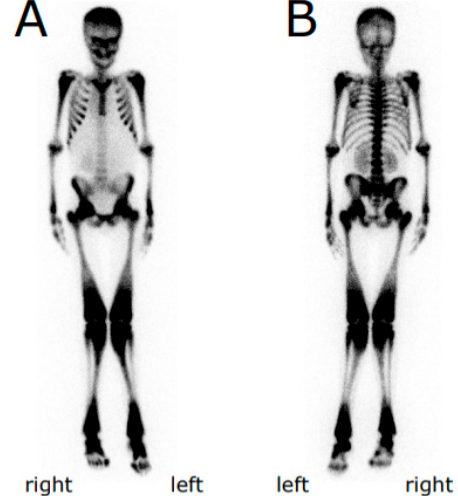
Figure 1. Bone scintigraphy of the proband. Anterior ( A ) and posterior ( B ) views. Metaphyses and diaphyses of humerus, femur, tibia and fibula are widened.